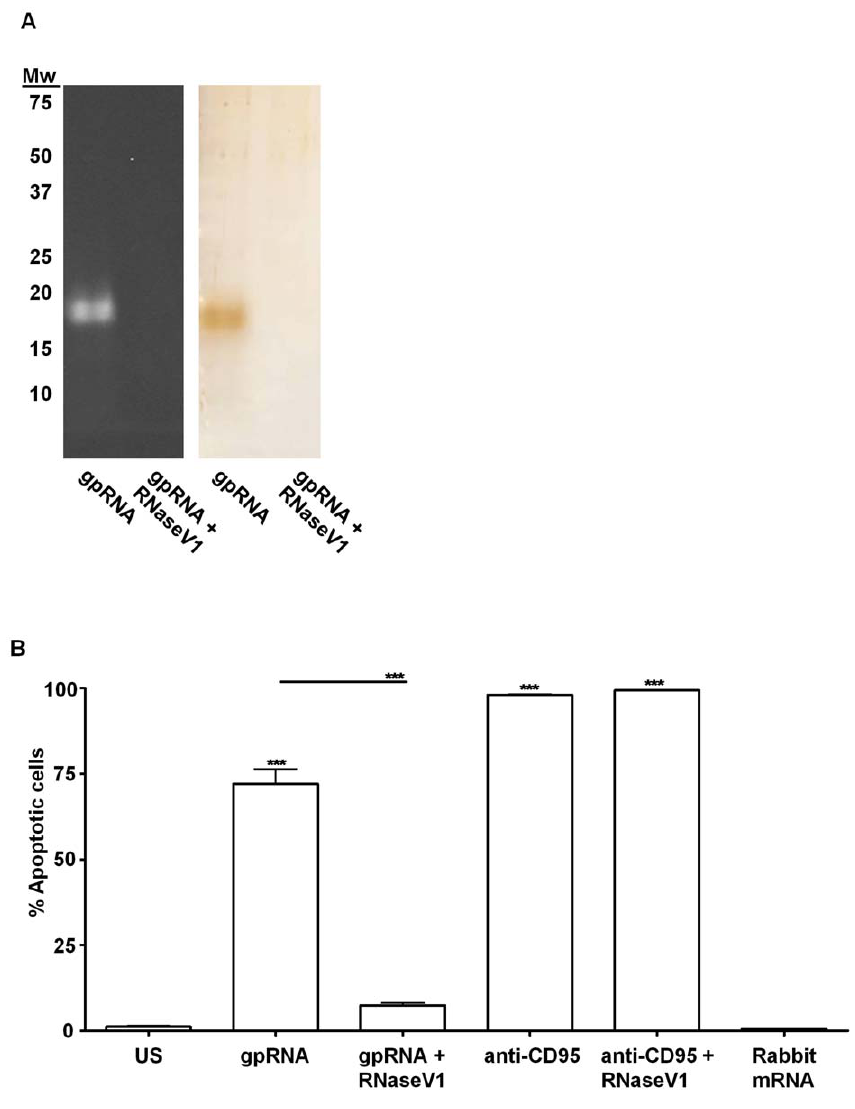
Figure 3. Human monocyte apoptosis is specifically induced by gel-purified mycobacterial RNA. A. SDS-PAGE with ethidium bromide (left) and silver stained (right) gel-purified RNA (gpRNA) from F7 and treated with RNaseV1 (gpRNA + RNaseV1). B. Monocyte apoptosis induced by gpRNA untreated or treated with RNaseV1, anti-CD95 untreated or treated with RNaseV1 (anti-CD95 + RNaseV1) and rabbit mRNA. Significance as described above.